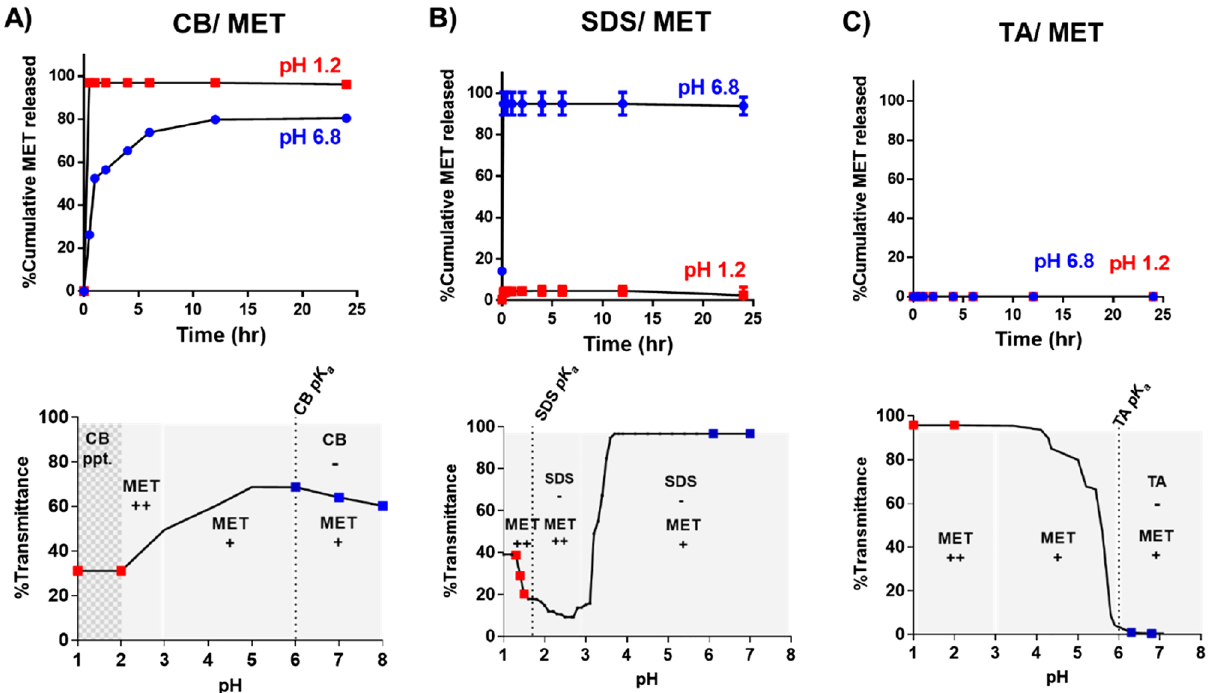
Figure 7. In-vitro release of metformin hydrochloride (MET) from complexes. ( A ) Carbopol/MET (CB/MET), ( B ) sodium dodecyl sulphate /MET (SDS/MET), and ( C ) tannic acid /MET (TA/MET) complexes of charge ratios 2:1, 1:1 (> CMC) and 3.3:1, respectively, and corresponding %transmittance-pH profiles of the three complexes with background indicating the ionization state of MET and ligands (release media; 0.2-M phosphate buffer of pH 6.8, and 0.1 N